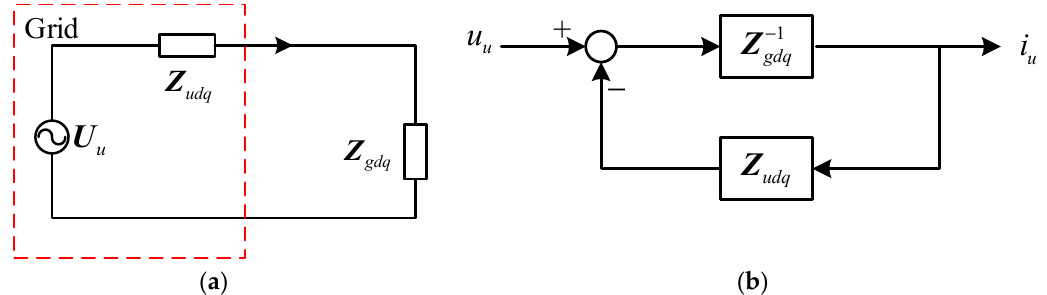
Figure 15. The equivalent circuit of the DFIG-based system. ( a ) The system’s equivalent circuit based on the grid output impedance and converter input impedance; ( b ) is the transfer diagram of the circuit described in ( a ), and the feedback loop can be used to evaluate the system’s stability by applying the Nyquist stability criterion.